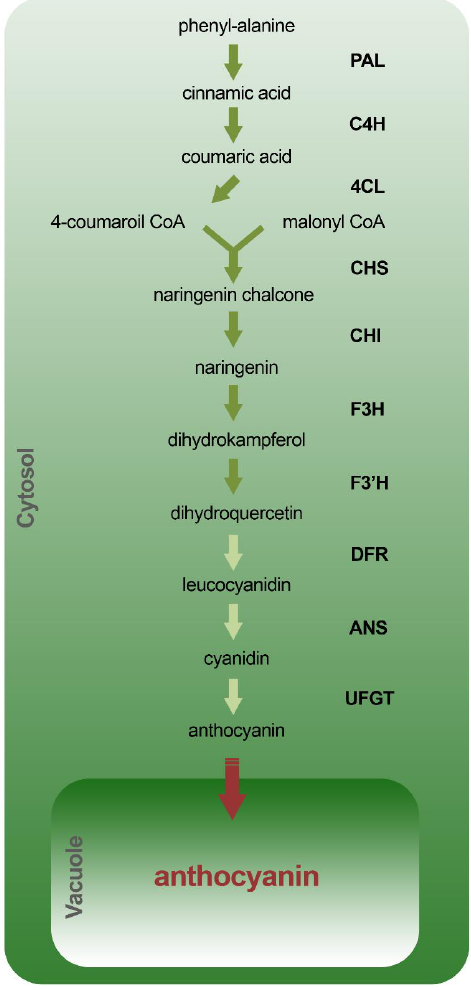
Figure 10. Schematic representation of anthocyanin biosynthetic pathway. PAL, phenylalanine ammonia-lyase; C4H, cinnamate-4-hydroxylase; 4CL, 4-coumaroil CoA ligase; CHS, chalcone synthase; CHI, chalcone isomerase; F3H, flavanone 3-hydroxylase; F3’H, flavonoid 3’-hydroxylase; DFR, dihydroflavonol reductase; ANS, anthocyanidin synthase; UFGT, UDP-glucose:flavonoid-3- O - glycosyltransferase.